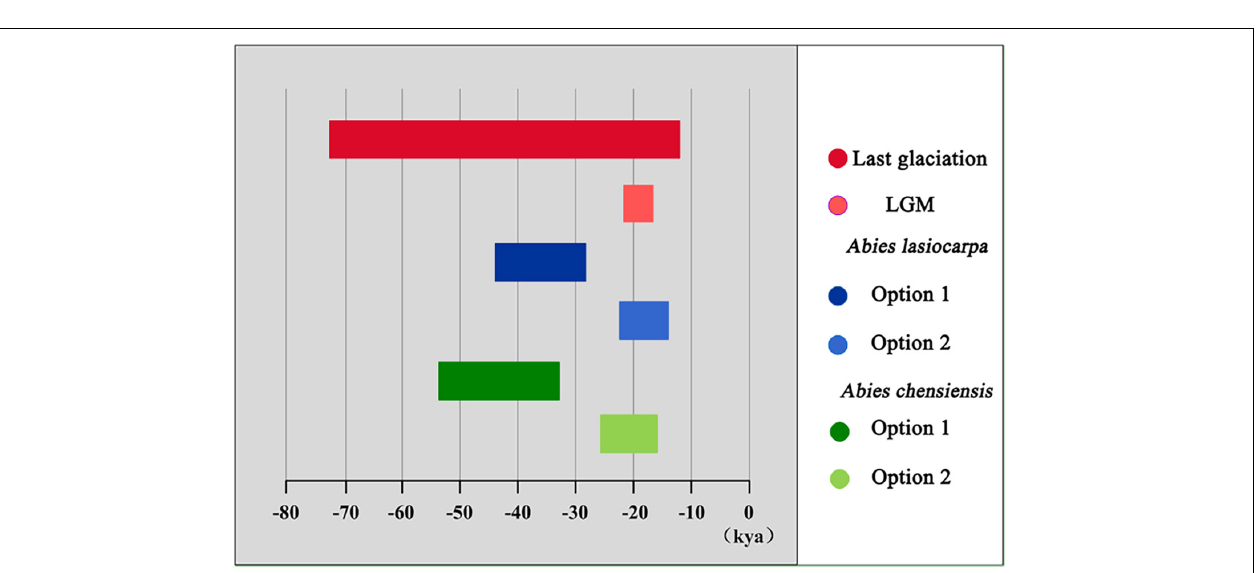
FIGURE 5 | Duration of recent range expansions detected in two high-elevation firs ( A. lasiocarpa and A. chensiensis ).